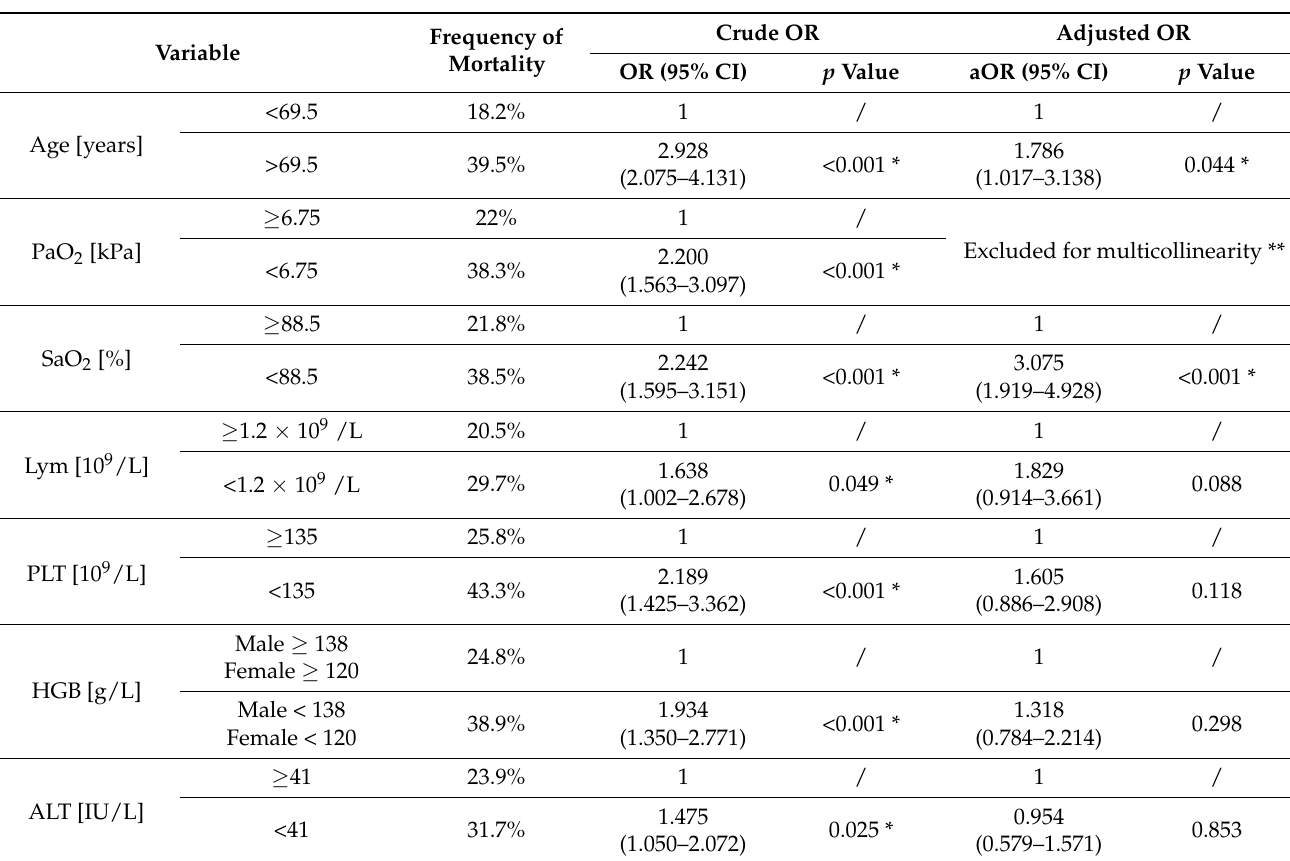
Table 3. Crude and adjusted OR values for variables available on hospital admission in regard to predicting in-hospital mortality of COVID-19